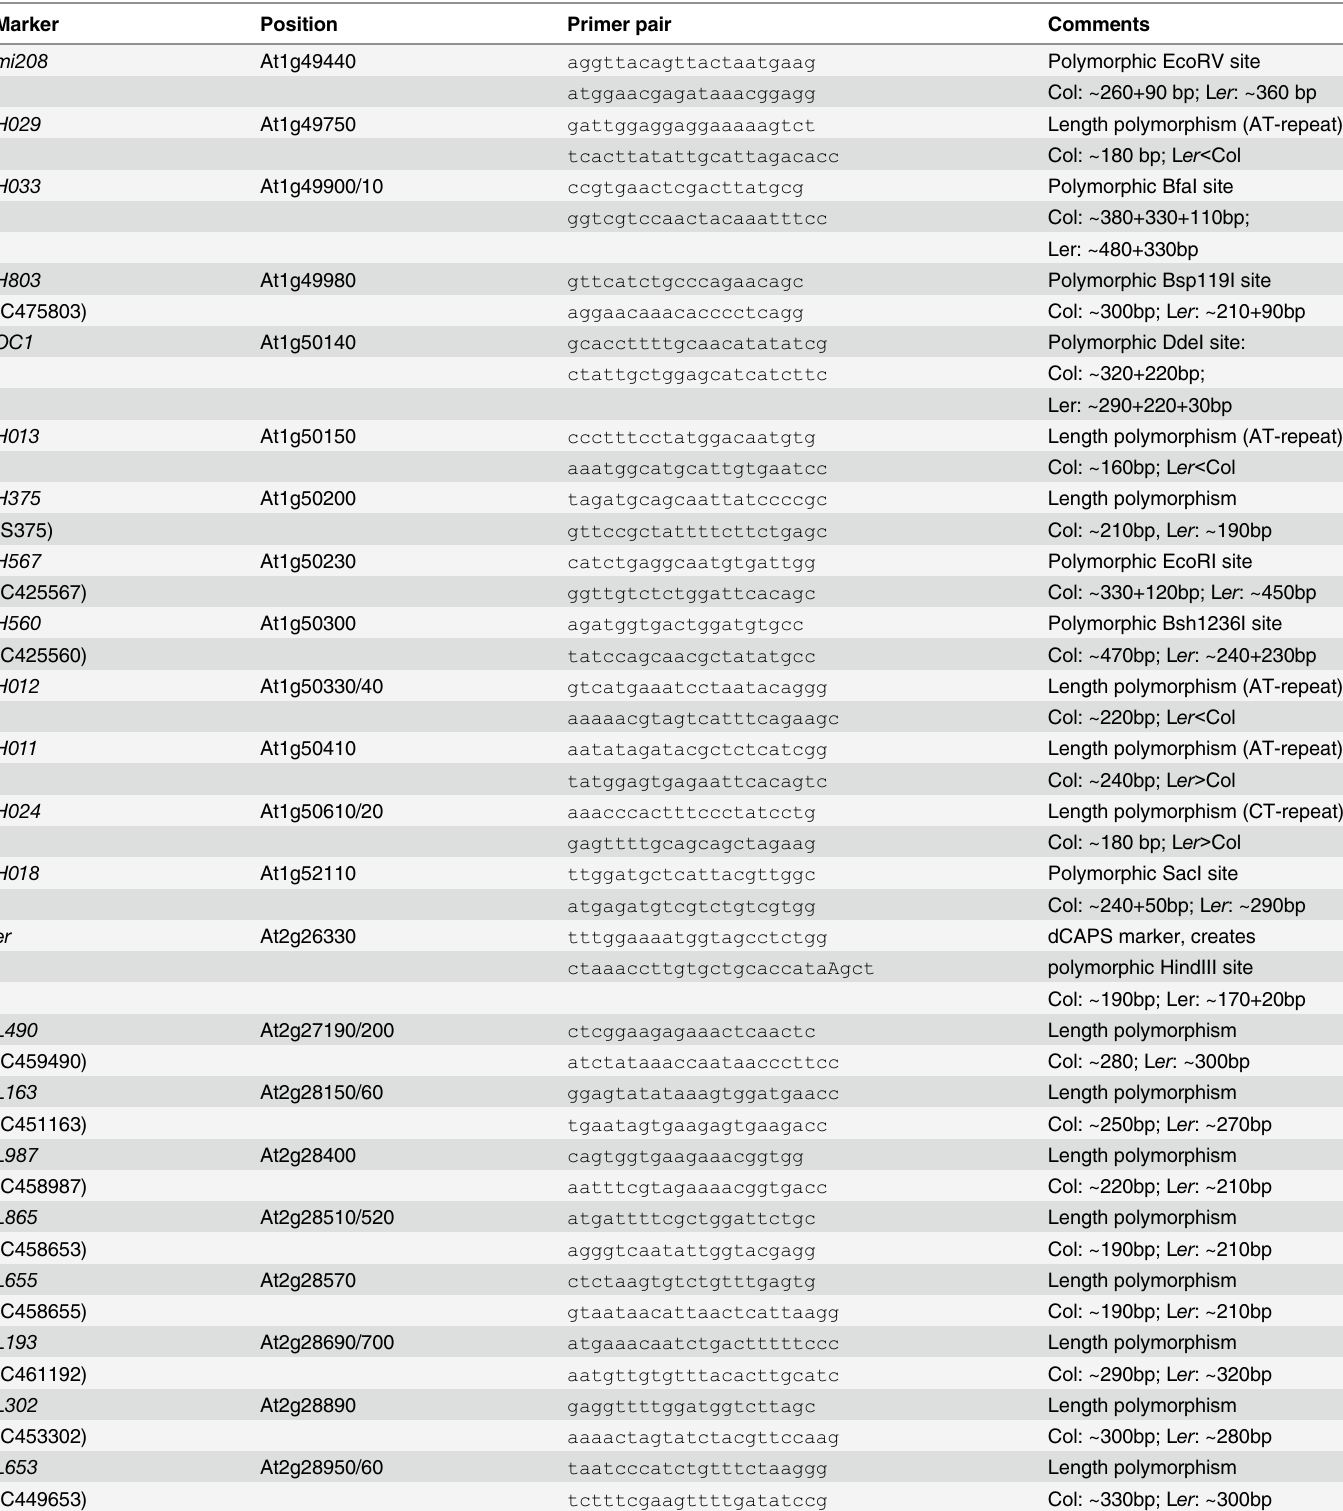
Table 1. PCR-based markers for molecular